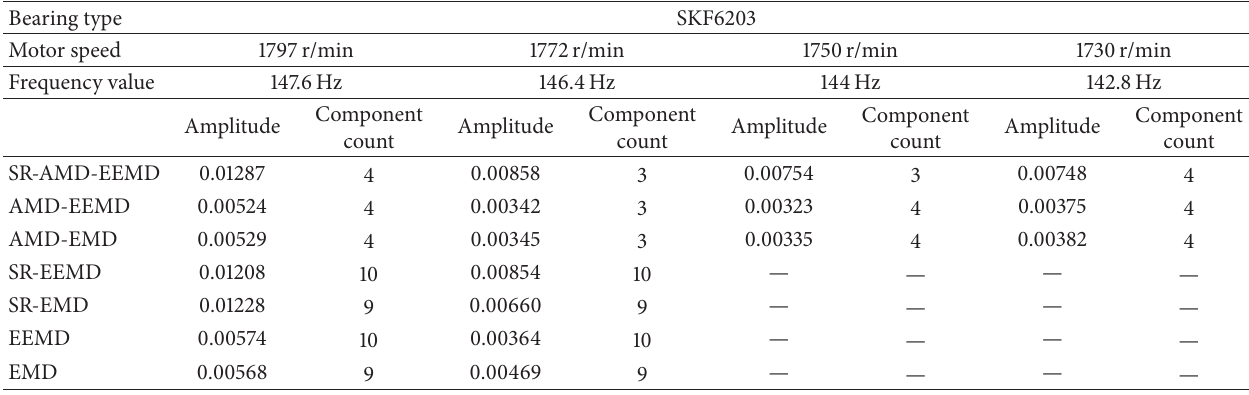
Table 6: The amplitude and component count of fault feature frequency of SKF6203 under different rotational speed. Bearing